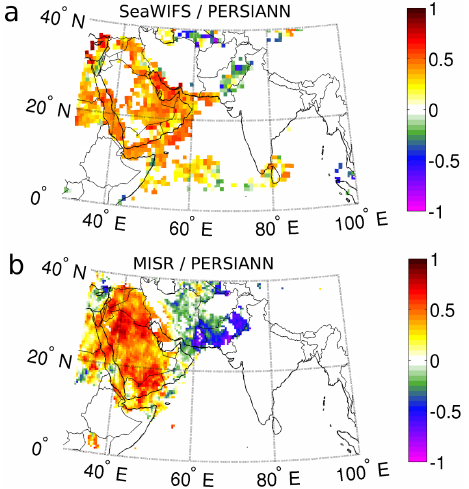
Figure 2. Interannual variability correlation coefficients calculated between deseasonalized summer (JJAS) AODs and deseasonalized JJAS precipitations averaged over a southern India box (5–20 ◦ N, 60–80 ◦ E): (a) based on the SeaWIFS AOD retrieval over the 1999– 2010 period and (b) based on MISR AOD retrieval over the 2000– 2010 period. Pixels showing monthly AOD < 0.2 are excluded from the calculation as well as pixels for which sampled valid year num- ber is less than 8. Figure 3. Linear JJAS AOD trend calculated over the 2000–2009